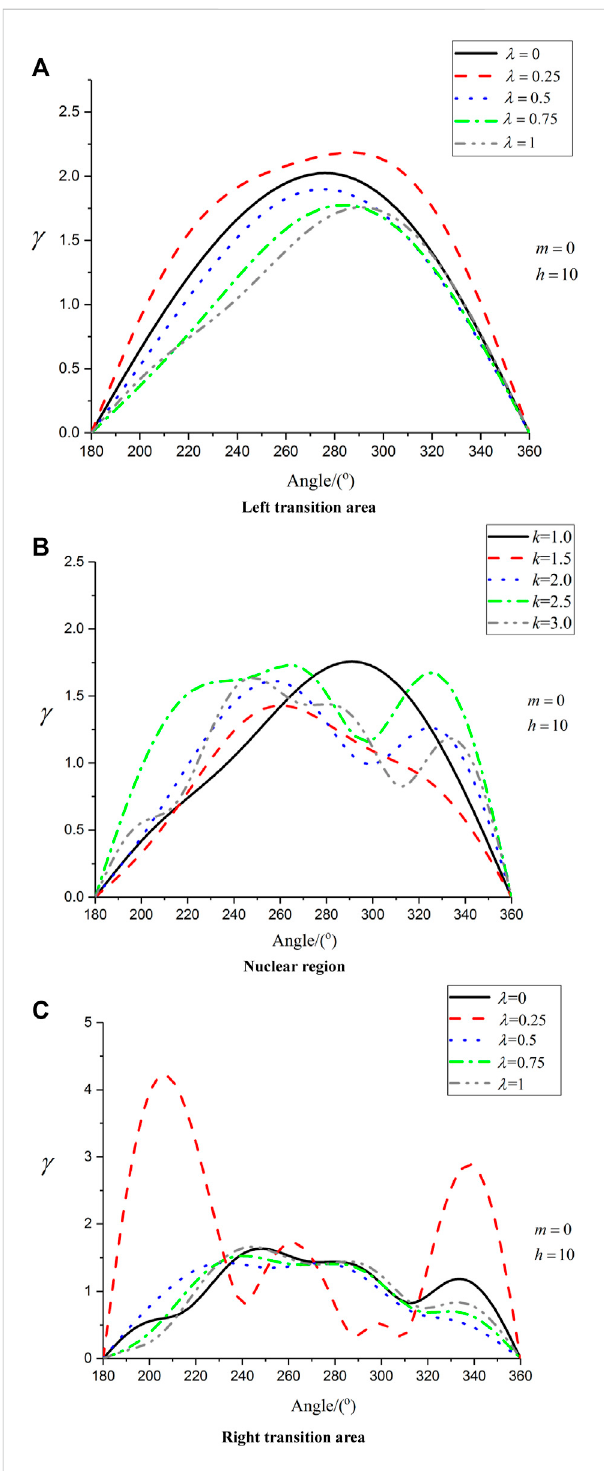
FIGURE 5 Distribution of hoop dynamic stress concentration factor of semi-circular depression when the thickness of the ribbon domain is h (cid:2) 10. (A – C) represent the results of these three subsets: Left transition area, Nuclear region and Right transition